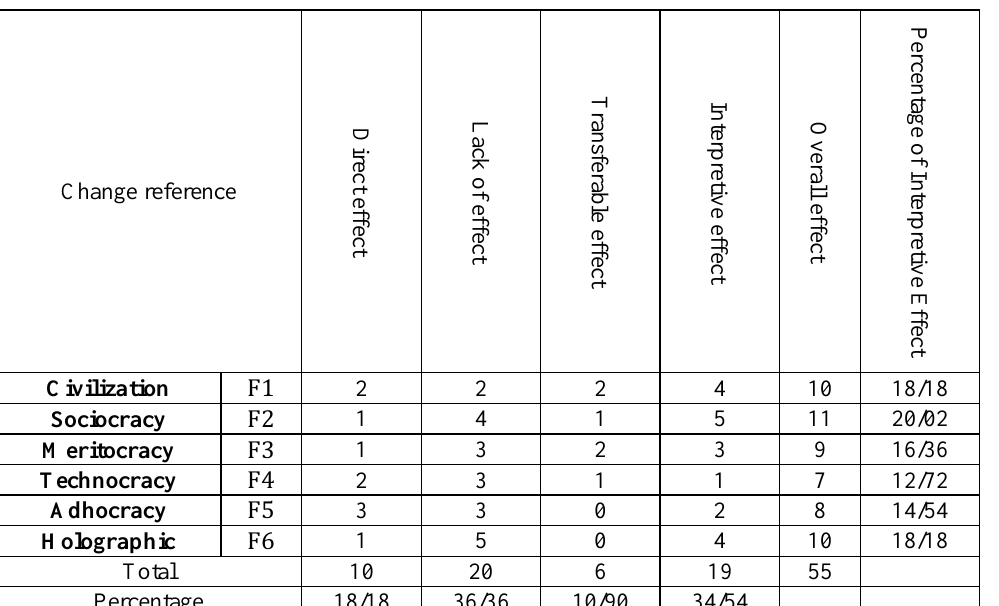
Table 13. Percentage of points of the level of influence Corporate Governance Civilization